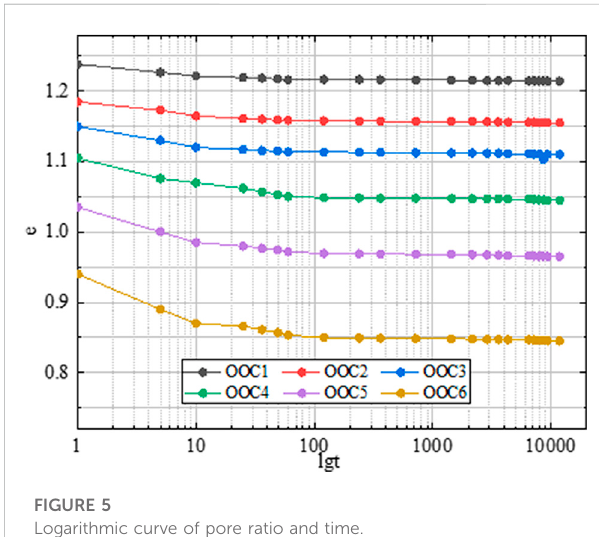
Logarithmic curve of pore ratio and time.